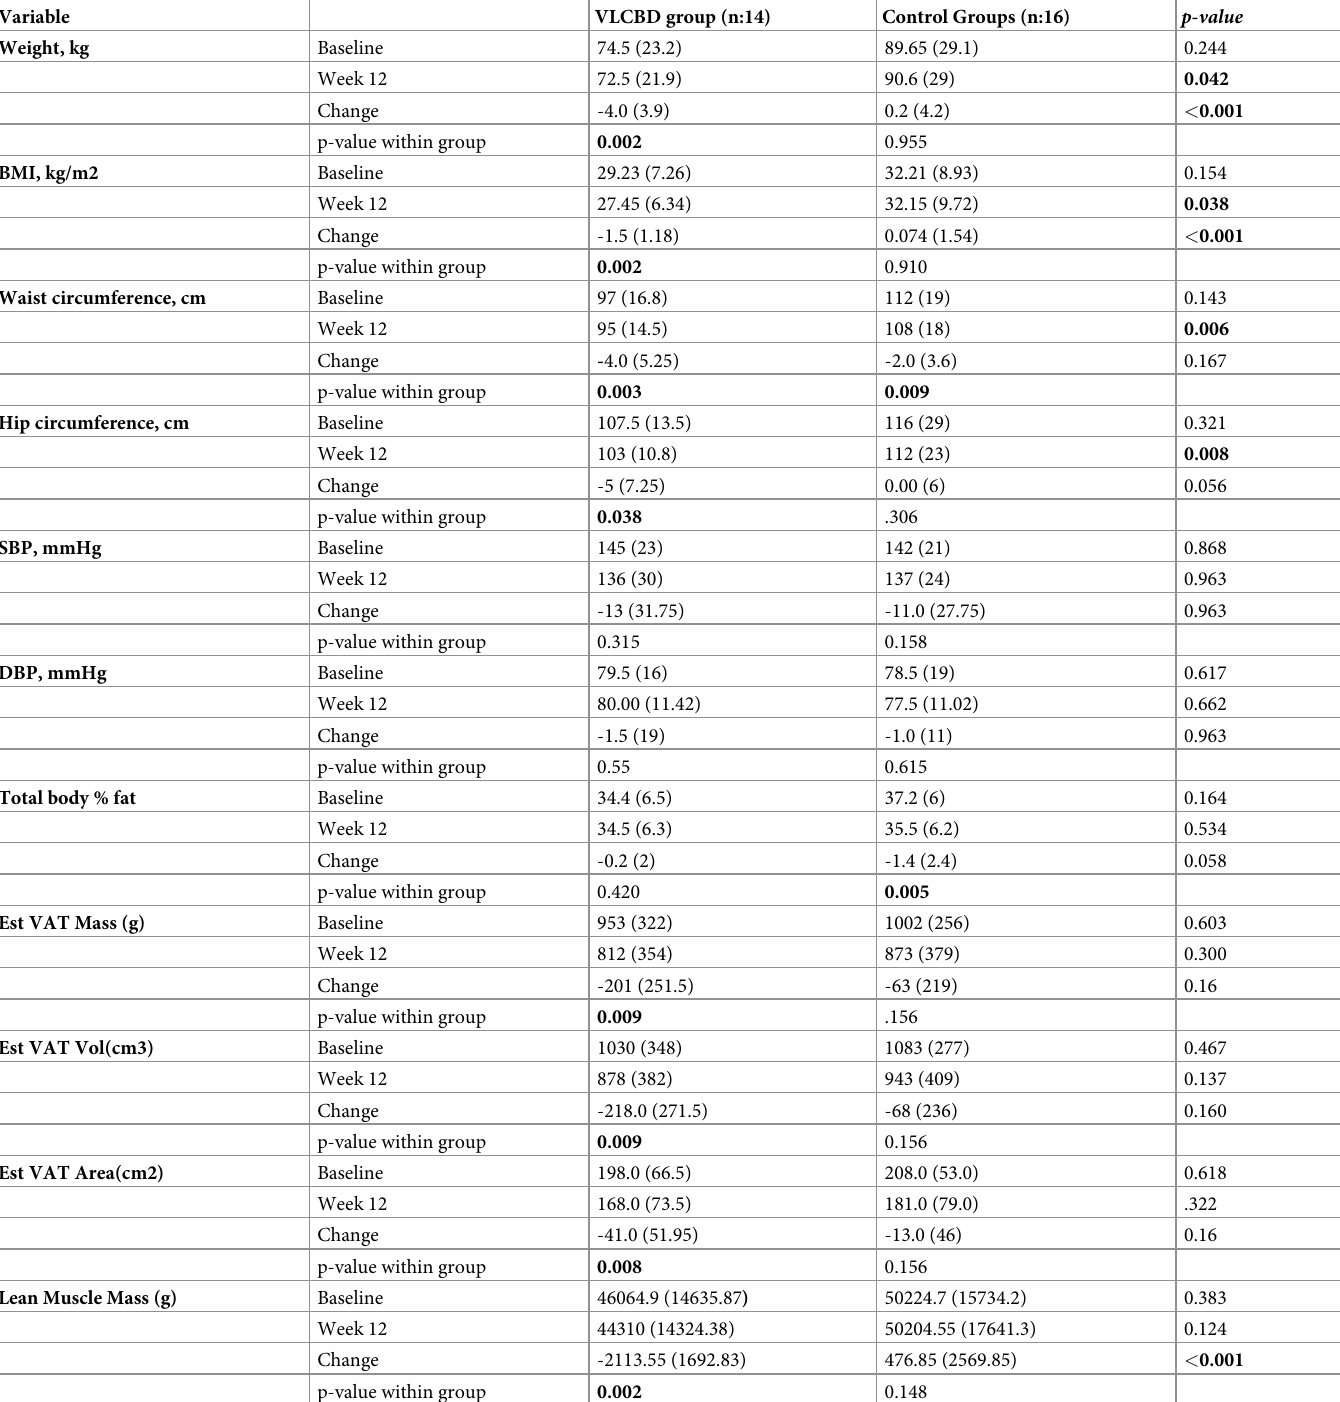
Table 3. Comparison of anthropometric and blood pressure changes between the VLCBD and LPD groups over 12 weeks of intervention.